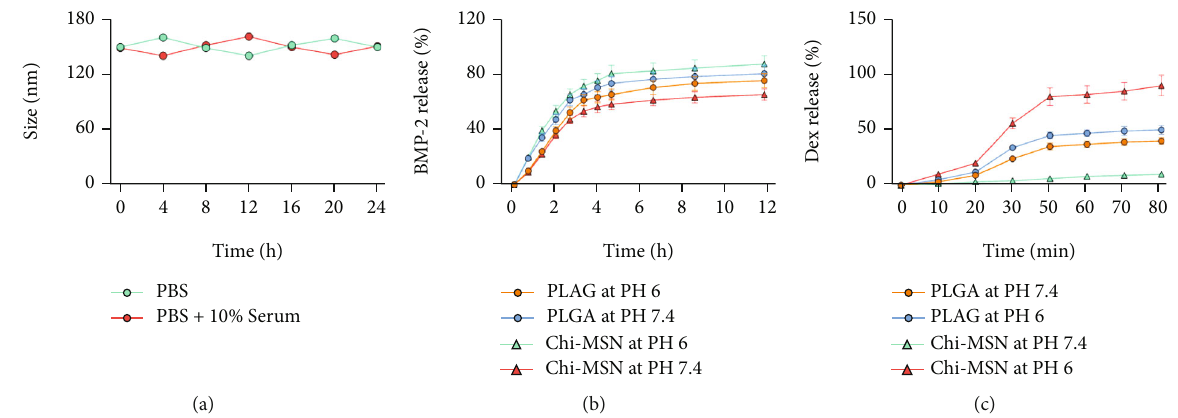
Figure 2: Physicochemical characterization of BMP-2@Chi-MSN. (a) Stability test of BMP-2@Chi-MSN at varied stored medium. (b) BMP- 2 release rate of PLAG and Chi-MSN at di ff erent pH. (c) Dex release rate of PLAG and Chi-MSN at di ff erent pH.